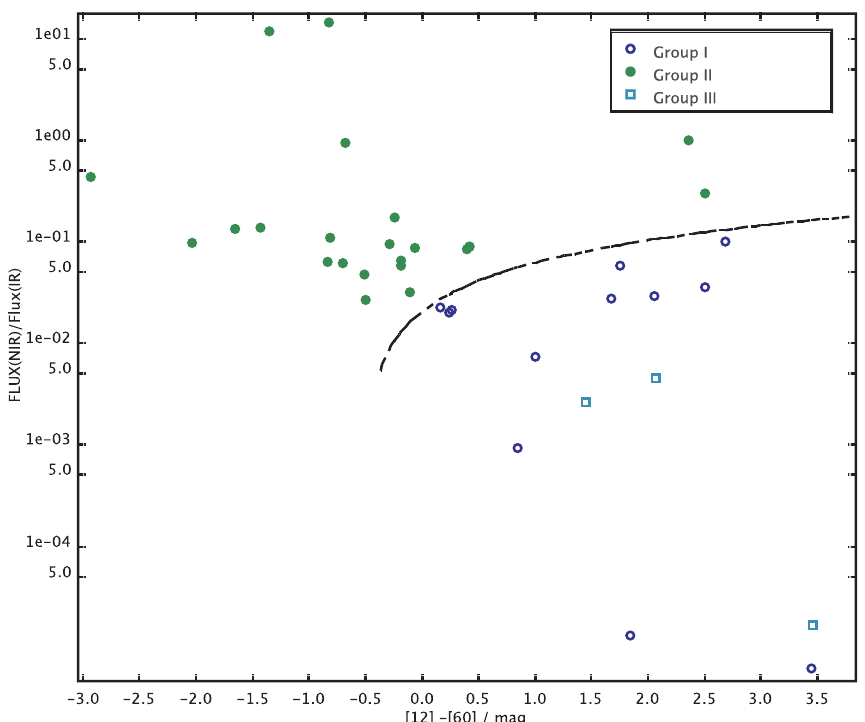
Fig. 2. The ratio of the near-infrared and infrared (cid:13)uxes versus the IRAS [12] (cid:0) [60] colour. Group I sources are plotted as open blue circles; group II, as (cid:12)lled green circles; and group III, as open cyan squares. The dashed curve indicates our division line between group II and groups I and III, F NIR =F IR = 0 : 04([12] (cid:0) [60]) + 0 : 02.